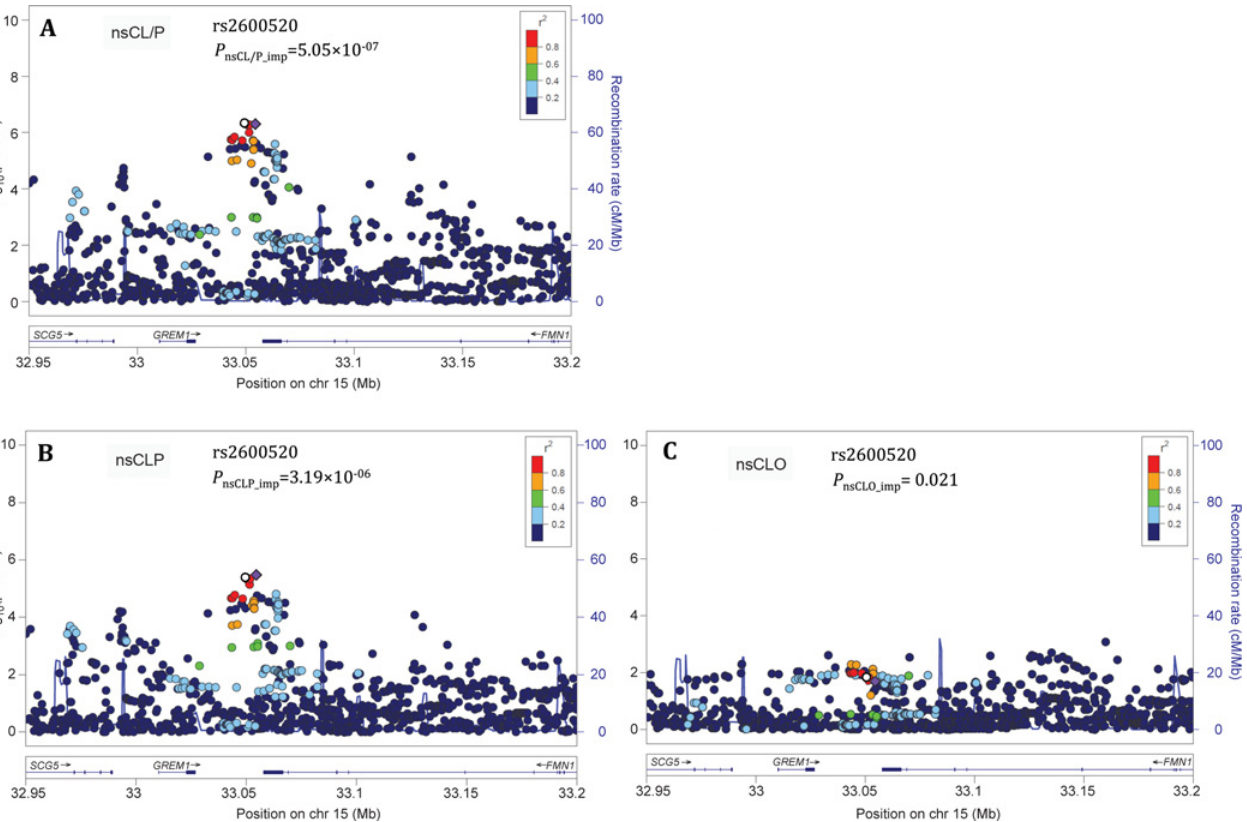
Fig 2. Regional association plots for the 15q13 region in different types of nsCL/P. In the imputed data of the Central European cohort, the 15q13 region was analyzed in the overall phenotype nsCL/P ( A ) and both subphenotypes, i.e. nsCLP ( B ) and nsCLO ( C ). For each SNP, the P -value is plotted against its chromosomal position (hg19). In nsCL/P and nsCLP, a highly associated cluster of SNPs in strong linkage disequilibrium is present, located between GREM1 and FMN1 . The lowest P -value was observed for rs2600520 (purple diamond). In each panel, the top genotyped variant rs1258763 is marked by an open circle. For all other variants, color code denotes linkage disequilibrium to rs2600520, based on 1000genomes. Regional association plots were generated using LocusZoom [28].